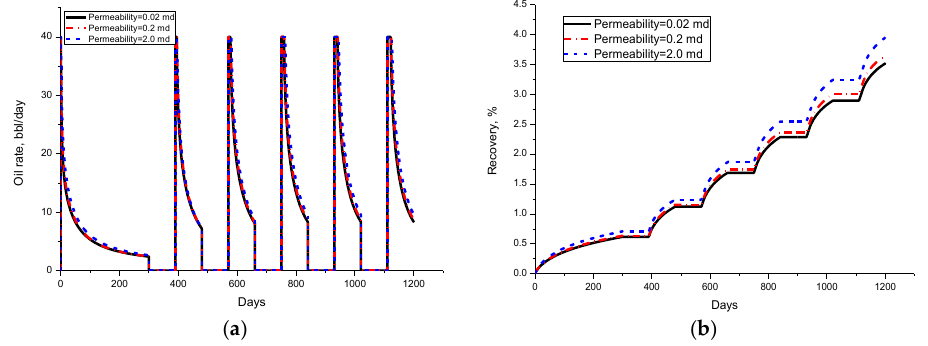
Figure 10. Simulation results for different natural fracture permeabilities. ( a ) Oil rate of different natural fracture permeabilities; ( b ) Recovery of different natural fracture permeabilities.